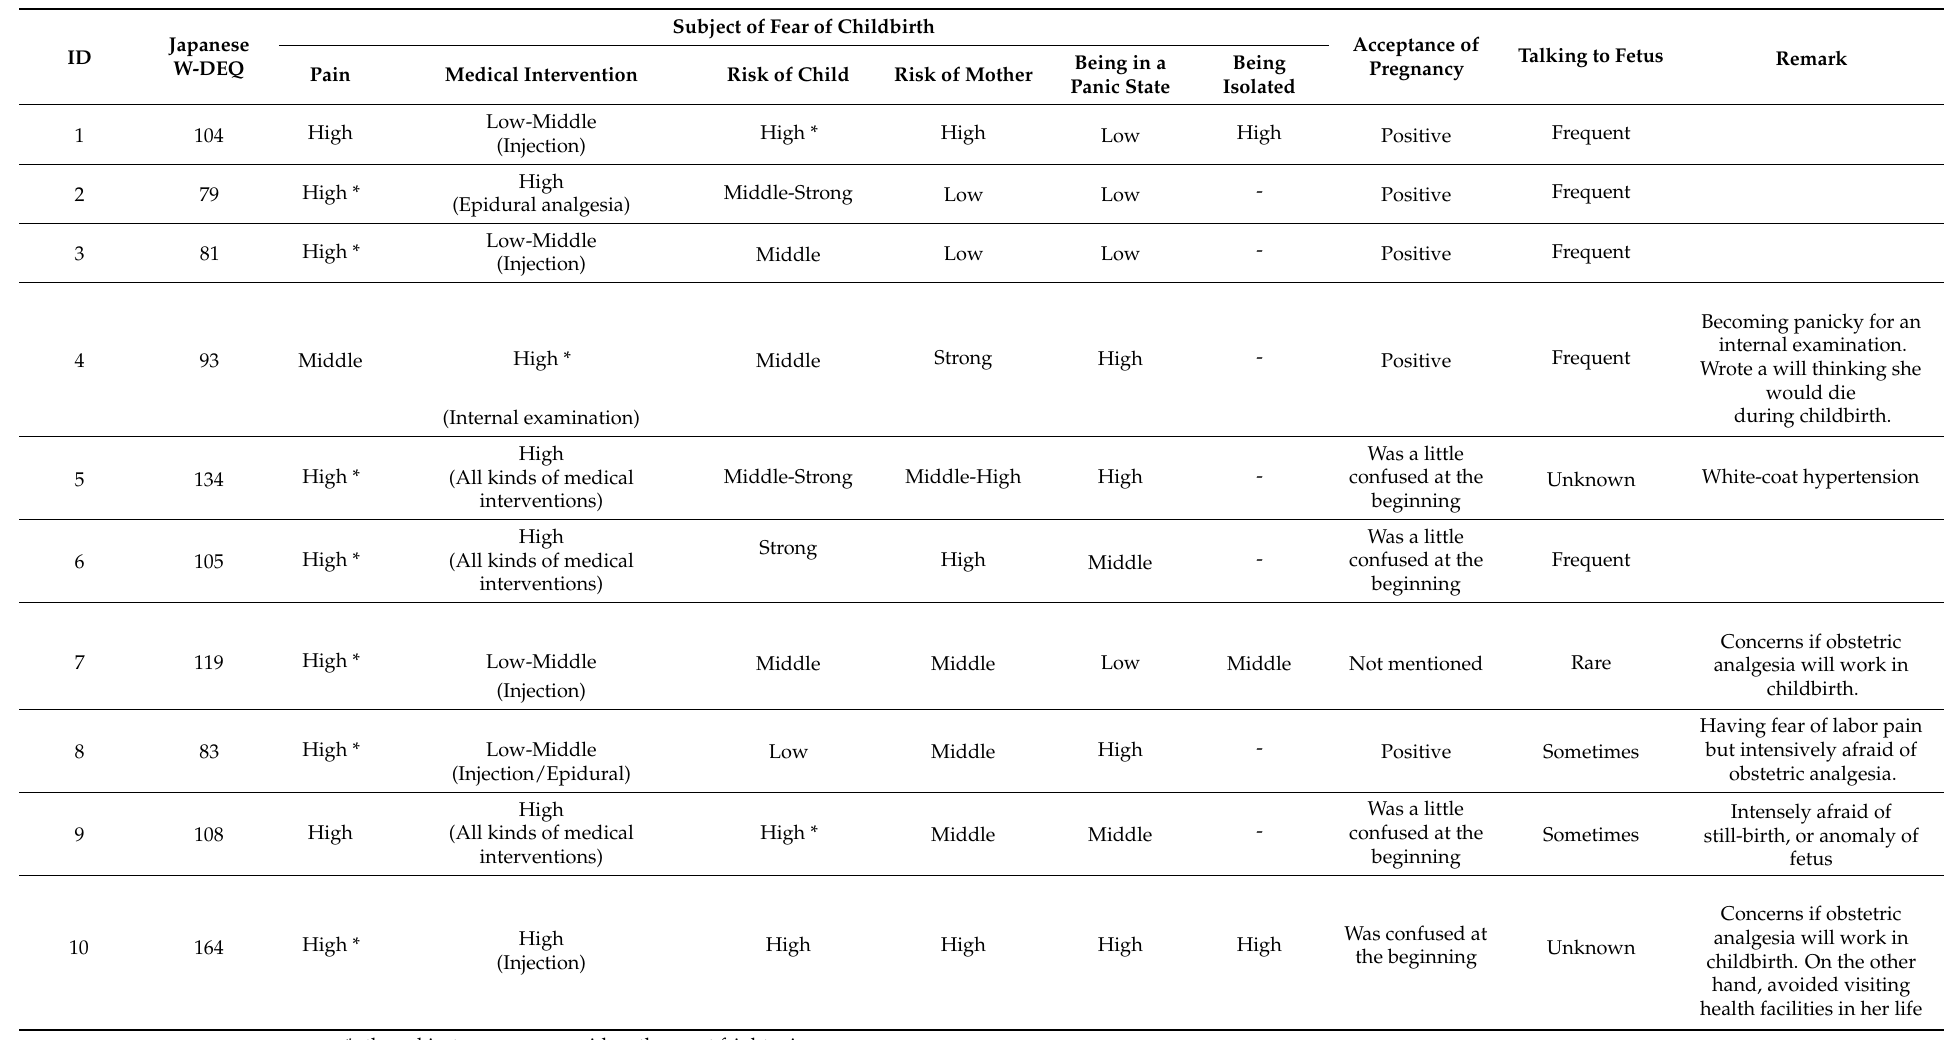
Table 2. Intensity and content of fear of childbirth among